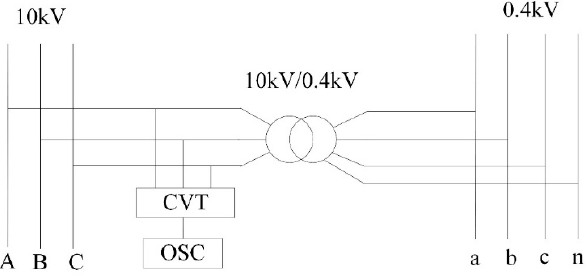
Figure 9. The wiring diagram of a traveling-wave measurement device.